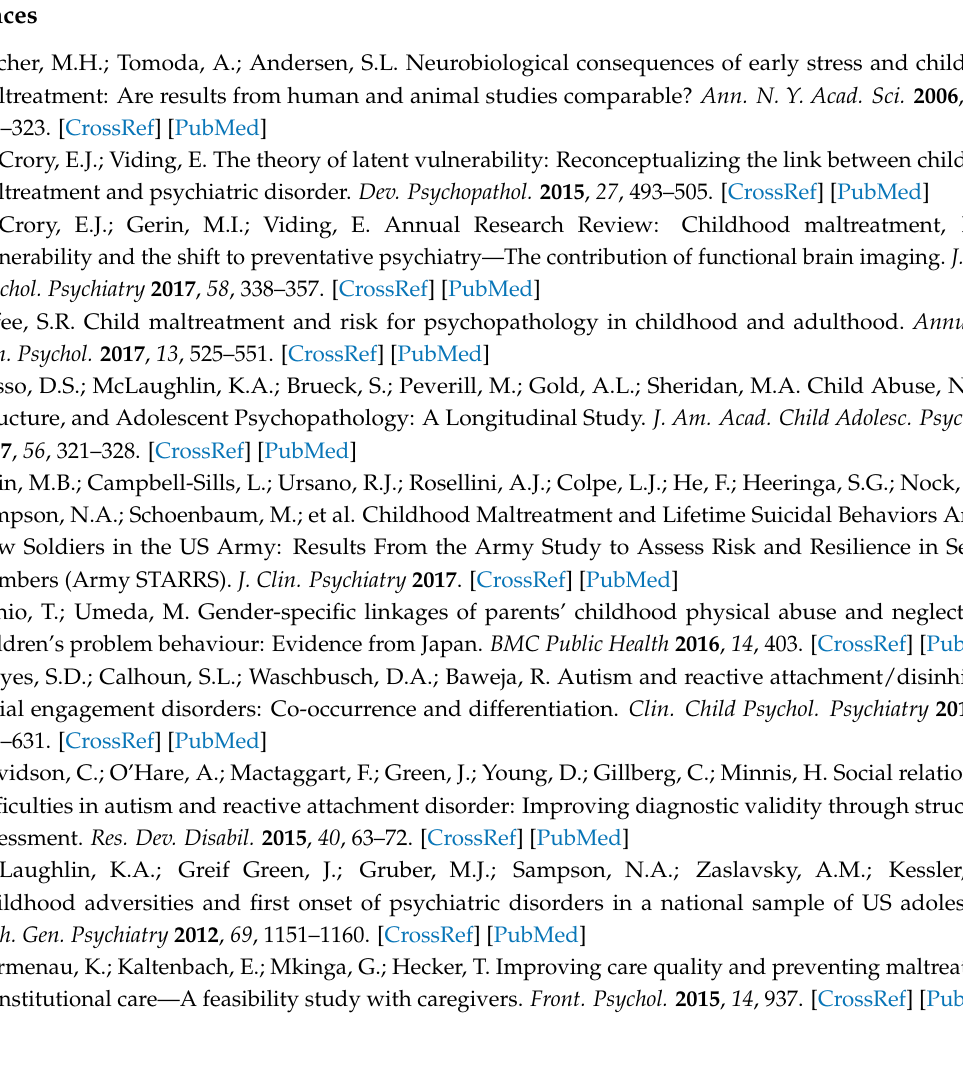
Figure S1: Various types of Wataiko (Japanese percussions) used for music intervention in group, Figure S2: Recitals performed in front of audiences in various stages in wearing with a festival uniform, Figure S3: Upper panels, practice in a hall; lower panels: free sessions, Figure S4: Oxytocin concentrations of individuals before recital and free play sessions, Figure S5: Changes in oxytocin concentrations of individuals before and after recital and free play